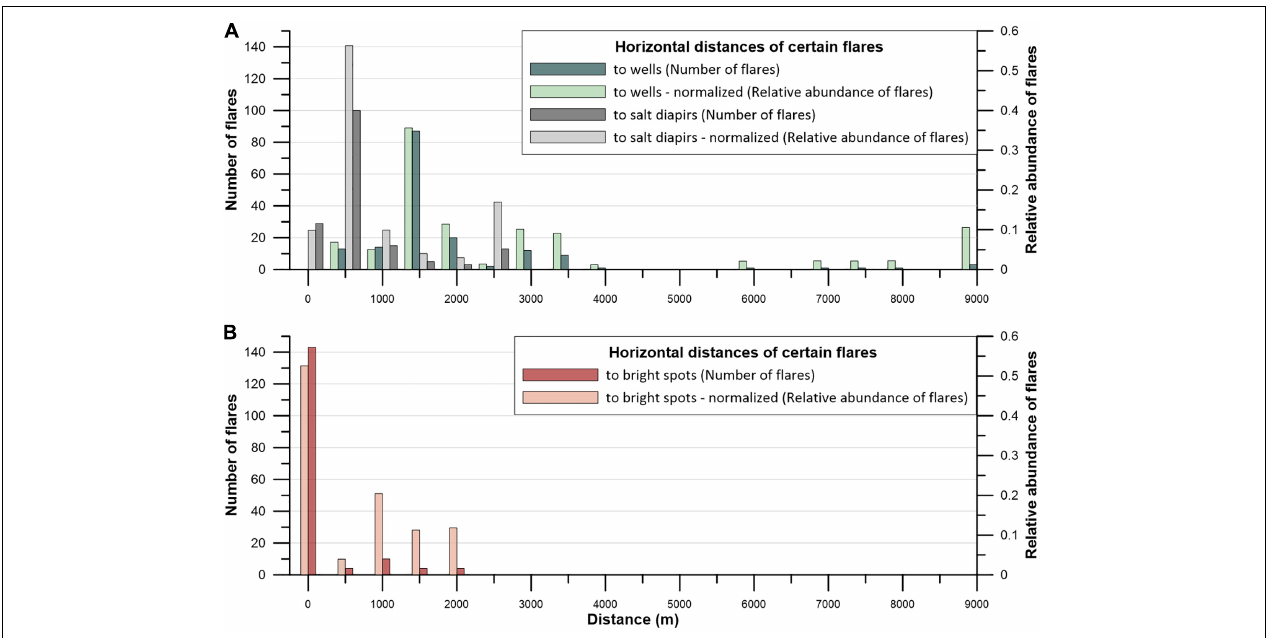
FIGURE 9 | Histogram plots showing the distances of flares to (A) salt diapirs, abandoned wells sites, and (B) bright spots (seismically identified). Only flares classified as certain were included. The histograms were binned at 500 m intervals, with the first bin = 0 m (flares plot above a salt diapir or bright spot area), second bin > 0–500 m, third bin > 500–1,000 m, ect. Darker colored bars illustrate the total numbers of flares, whereas the lighter colored bars indicate the relative abundance of flares including a normalization by the ship track coverage. The normalization corrects for the non-uniform mapping strategy in the study